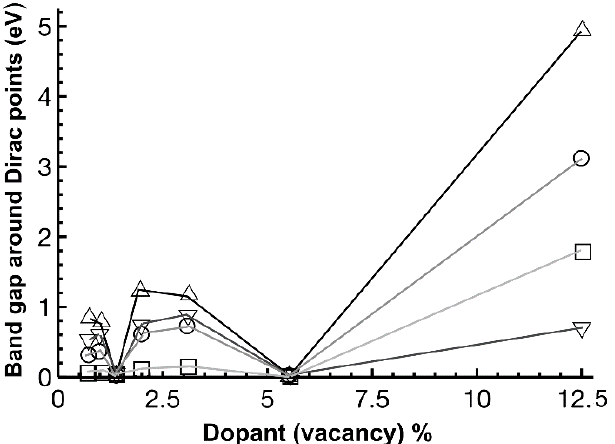
Figure 14. We show the bandgap variation around the Dirac points for different dopant (vacancy) percentage densities. Nitrogen: (cid:53) ; oxygen: O; Fluorine: (cid:52) ; vacancy: (cid:3) . We drew the lines only to keep track of the changes for each dopant. The bandgap collapses to zero for the unit cell sizes that follow the 3N rule [23] (1.39% and 5.55%).